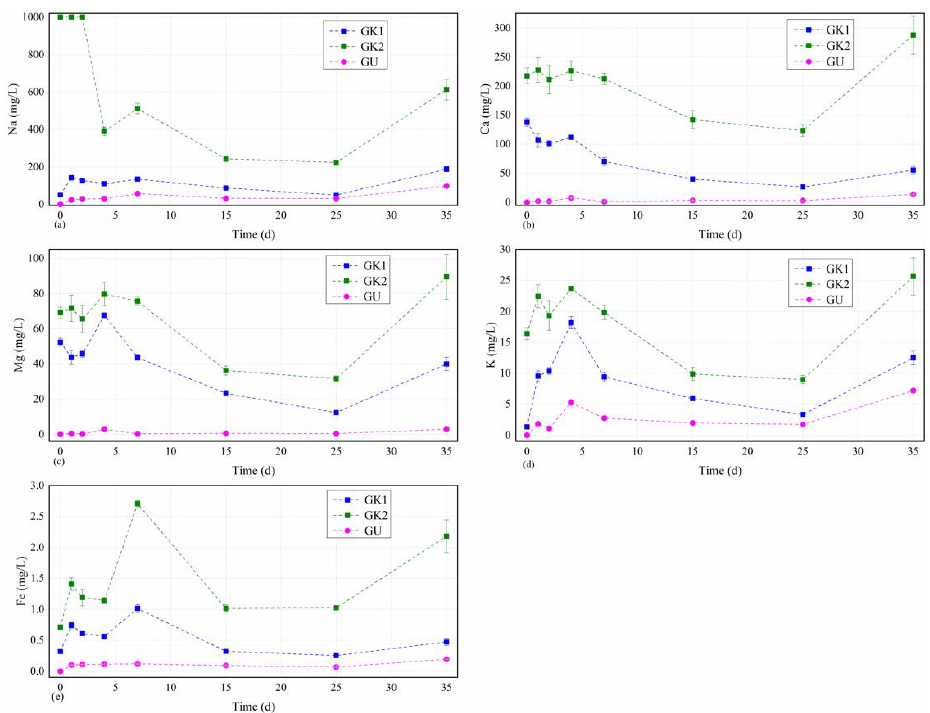
Figure 4. Concentrations ’ variation of several main cations in different immerse solutions over time. (a.Trend plot of Na ions in immersion solution over time; b.Trend plot of Ca ions in immersion solution over time; c.Trend plot of Mg ions in immersion solution over time; d.Trend plot of K ions in immersion solution over time; e.Trend plot of Fe ions in immersion solution over time)